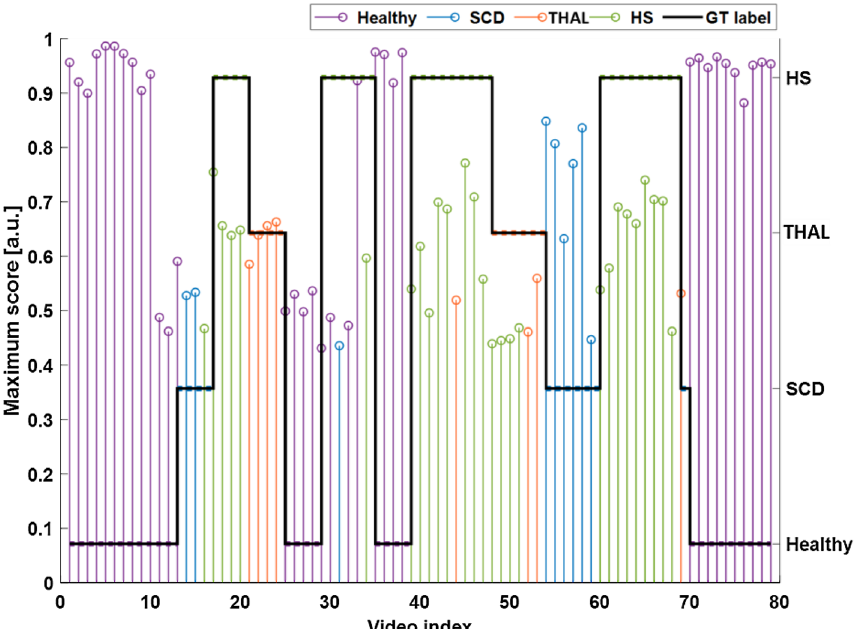
Figure 4. Sketch of the scores assigned to each of the 79 videos and related ground truth label. The height of the vertical bars represents the maximum score obtained for the assigned class; Colors indicate the category assigned according to the legend to the top-right corner. The black solid stair line indicates the expected category for each video as indicated by the right y-axis labels. As it can be observed, the healthy class (purple lines) are very well recognized and the related normalized score is very high, indicating that the scores of the unassigned class were very low. The visual results also confirm the fact that there are no false negative healthy subjects (i.e., a subject with a disease assigned to the healthy category) as also represented in the confusion matrix. Regarding the three anemia conditions, the values of the scores are smaller indicating the critical task to solve, but also in this case, there are a very few errors of classification, mostly due to the misclassification between THAL and HS samples (e.g., video n. 44 should be HS and instead is assigned to THAL, and videos n. 48–51 that should be THAL and are assigned to